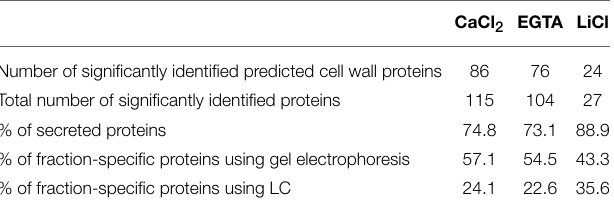
TABLE 3 | Information about the cell wall proteins (CWPs) detected in the fractions of the hybrid protocol by 2D-electrophoresis.